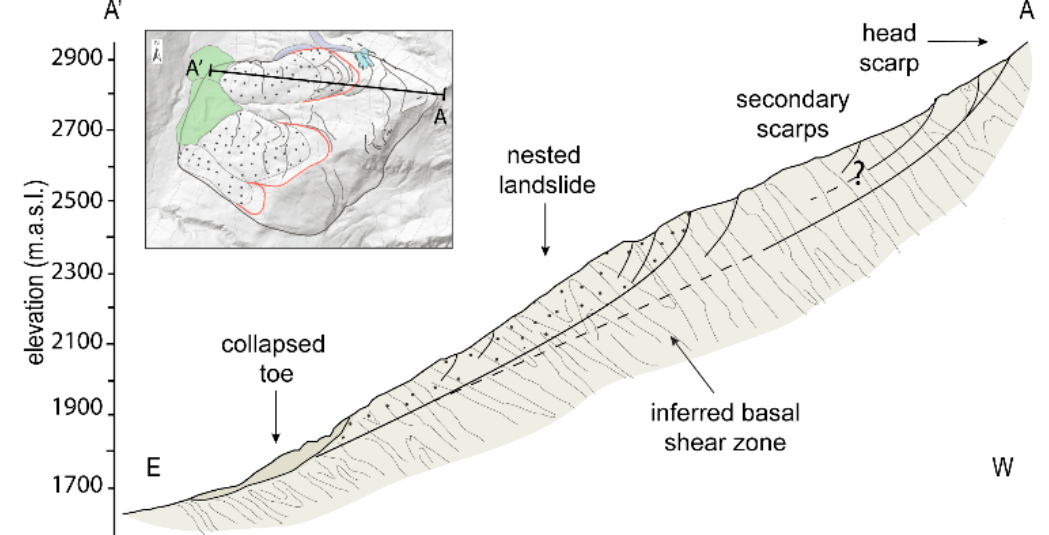
Figure 7. Interpretative cross-section across the northern sector of the Mt. Mater slope. DSGSD morpho-structures, basal shear zones and nested landslides are reconstructed from field evidence and interpretation of DInSAR displacement patterns. Cross-section trace is shown in the inset.